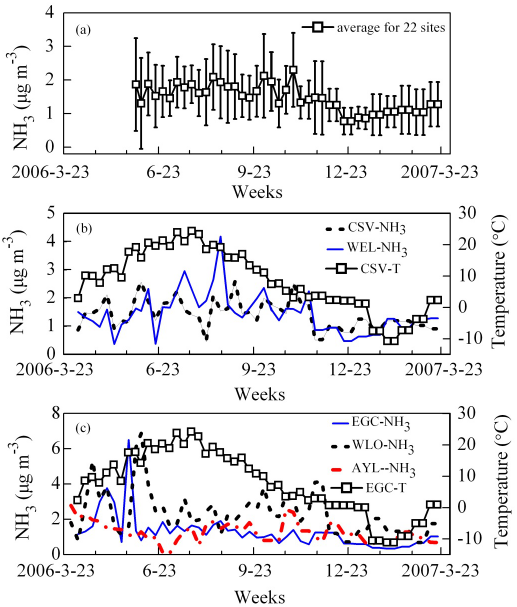
Fig. 3. Temporal variations of NH 3 in 2006–2007 at sites located in the medium concentration zones but without spikes during the coldest temperature periods: (a) the spatially averaged value over 22 sites, (b) two sites having no spikes before the early of June, and (c) three sites having spikes before the early of